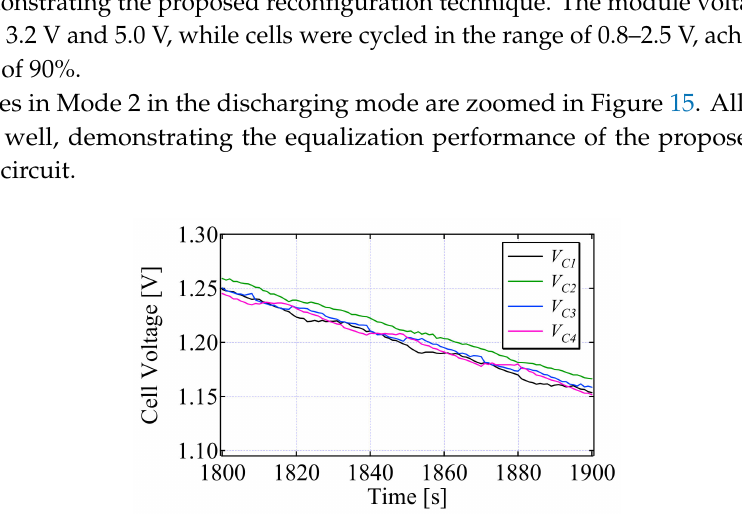
Figure 15. Zoomed cell voltage profiles in Mode 2 in discharging